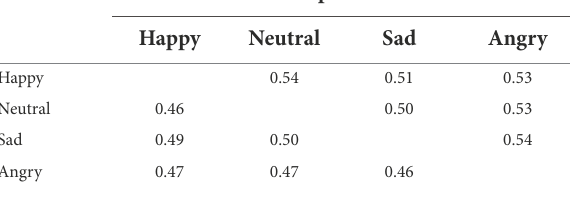
TABLE 7 Average ratio of chosen emotions in 5,000 ms presentation of Experiment